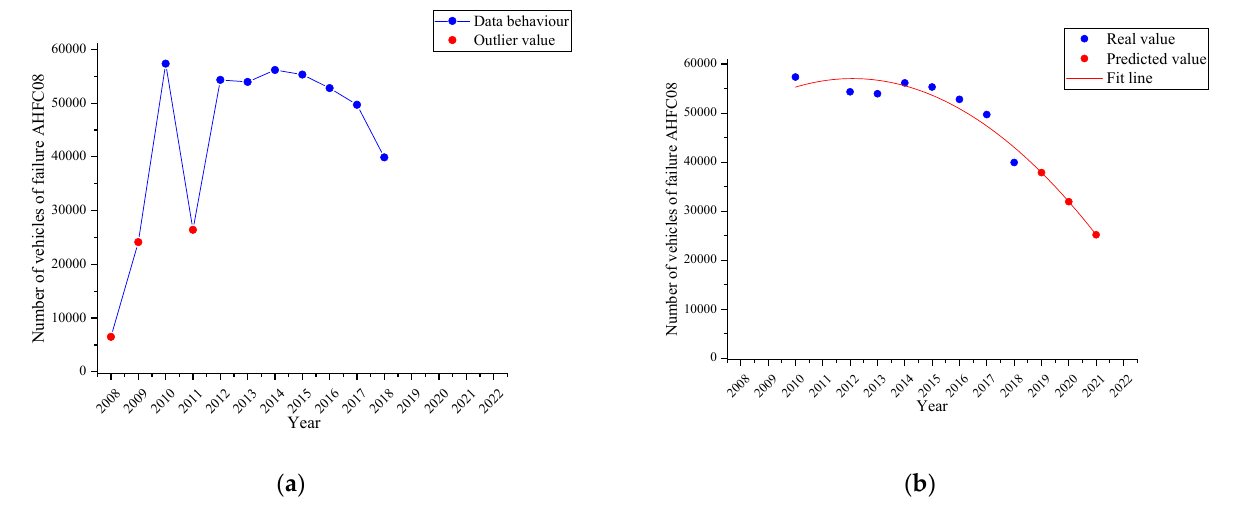
Figure 8. Failure trend named as horizontal alignment of the driver headlight (AHFC08). ( a ): behaviour of the failure AHFC08 (blue line); ( b ): the time series with a quadratic trend (red line) and the forecast (red dots).